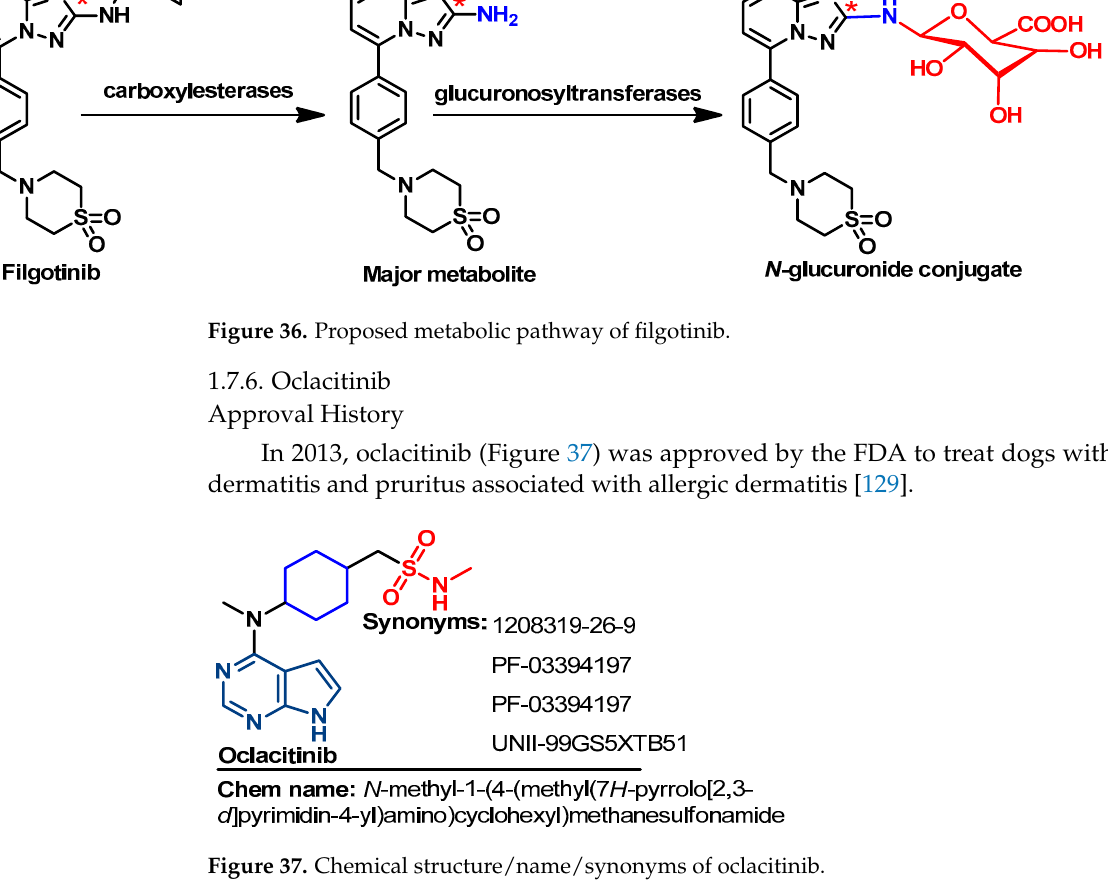
Figure 37. Chemical structure/name/synonyms of oclacitinib.